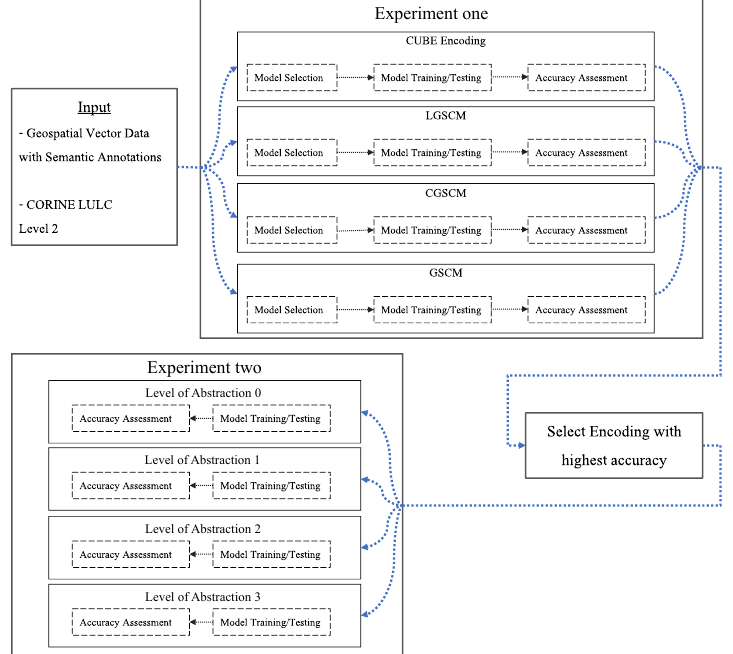
Figure 1. An overview of the workflow. CORINE LULC Level 2 data and geospatial vector data are used as input. Experiment one was carried out before Experiment two , and Experiment two was based on the outcome of Experiment one . In particular, in Experiment one , four different encodings were used to transform the geospatial vector data and its semantic annotations for predicting the LULC ground truth (given from CORINE). For each encoding, a separate processing pipeline for hyperparameter search and model training/testing (with accuracy assessment) was created. After Experiment one was finished, Experiment two was carried out. Experiment two used the best performing encoding (determined in Experiment one ), however with different semantic granularities (i.e., LoA). Please note that the data with LoA 3 in Experiment two is the same data as used in Experiment one , as it uses all the available semantics (OWL